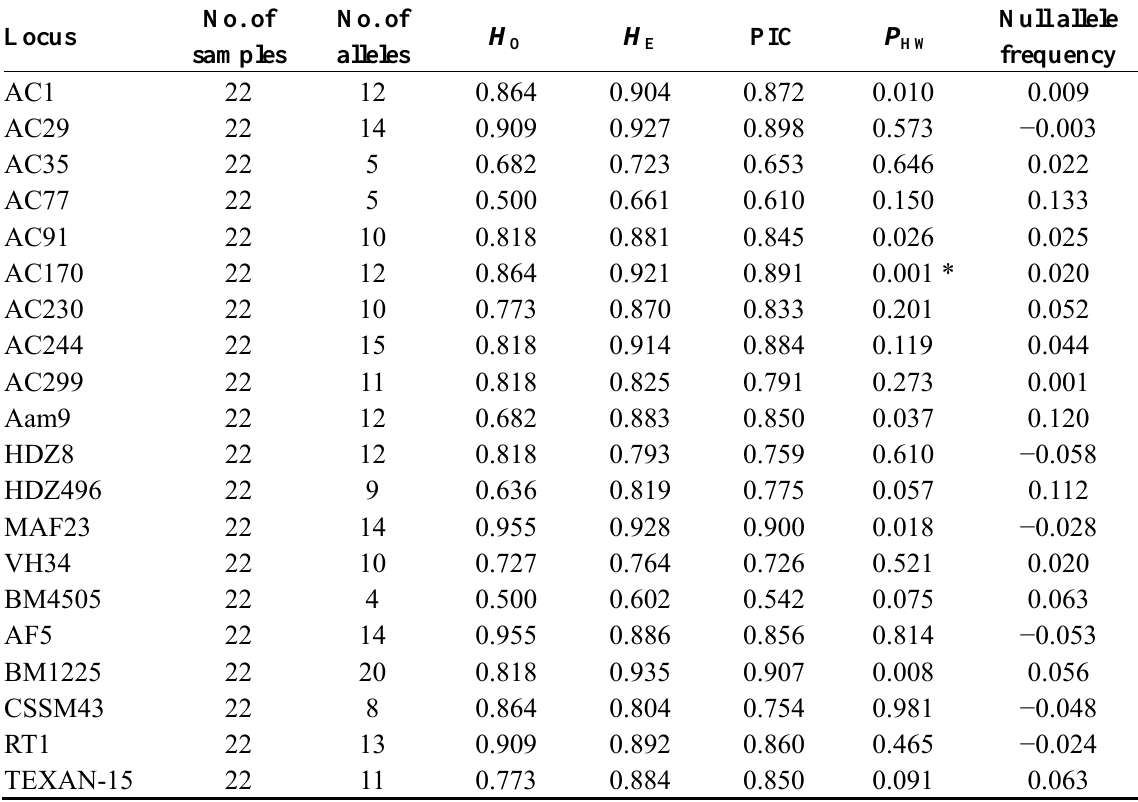
Table 3. Characterization of the twenty cross-species microsatellite loci in P. gutturosa